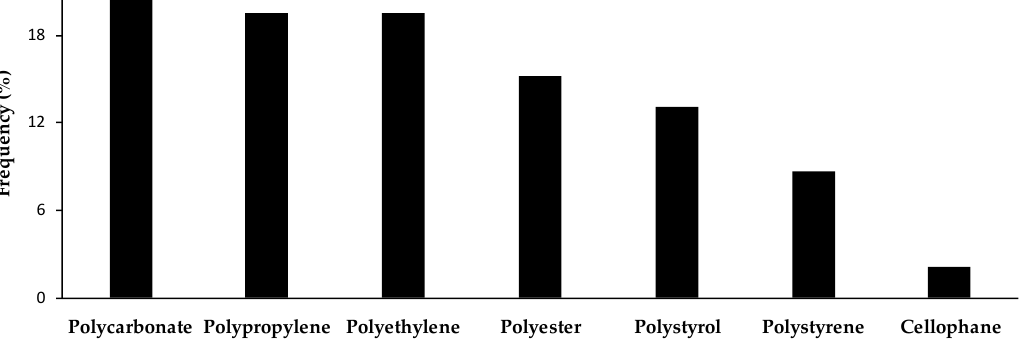
Figure 3. Proportion of plastic polymer type (%) found in Xyrichtys novacula gastrointestinal tracts in Eivissa Island (Balearic Islands, Spain).